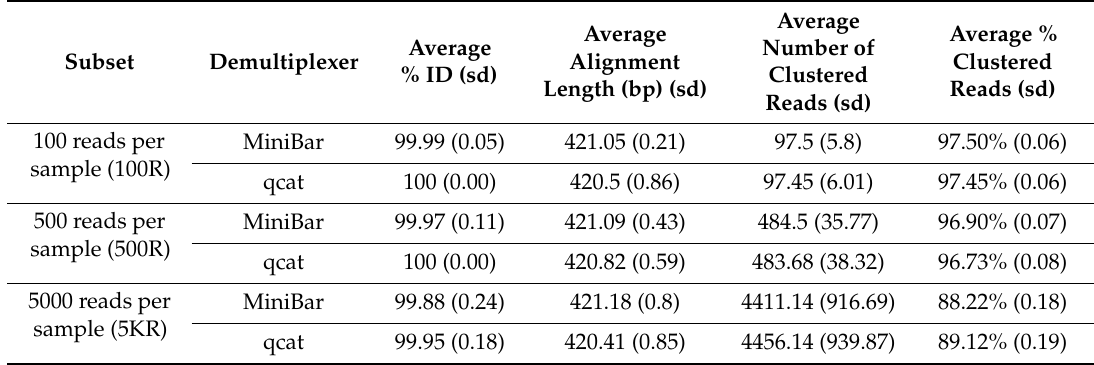
Table 1. Average and standard deviation (sd) for percent sequence similarity to Sanger sequence, length of matching nucleotides, and number and percent of demultiplexed reads used for the final consensus sequence from 100R, 500R, or 5KR read subsets demultiplexed with MiniBar or qcat. Statistics were calculated across all tissue types and extraction method samples.